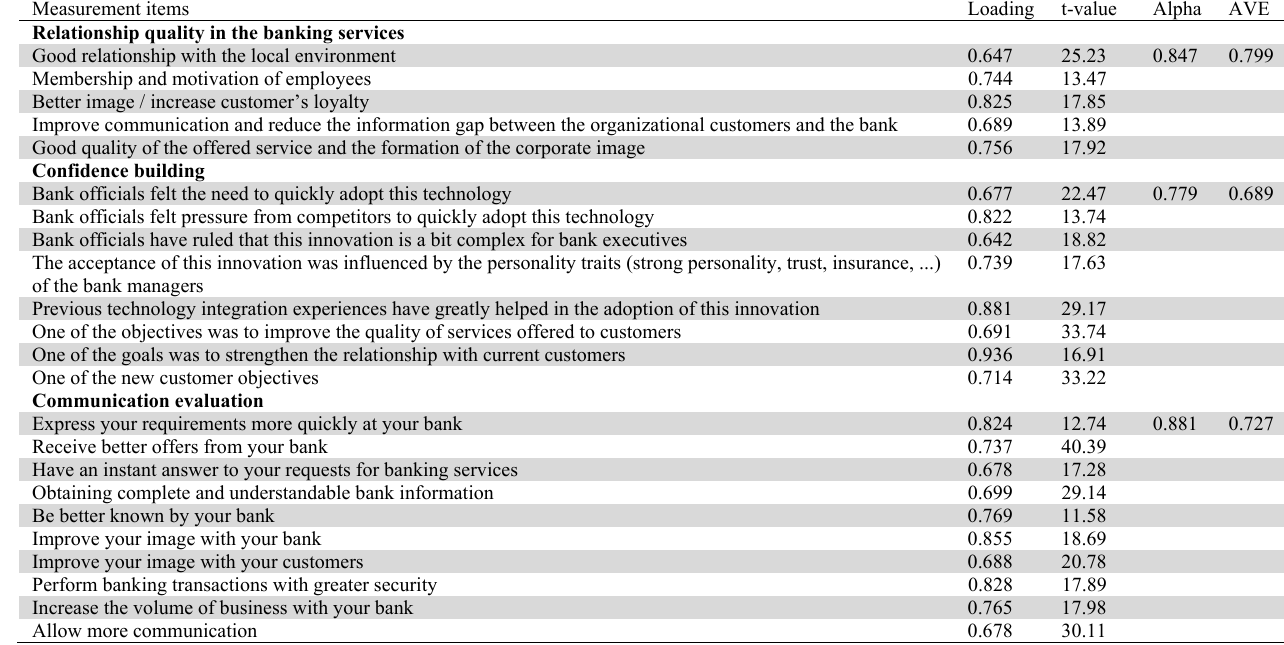
Factor loadings and t-values for each measurement